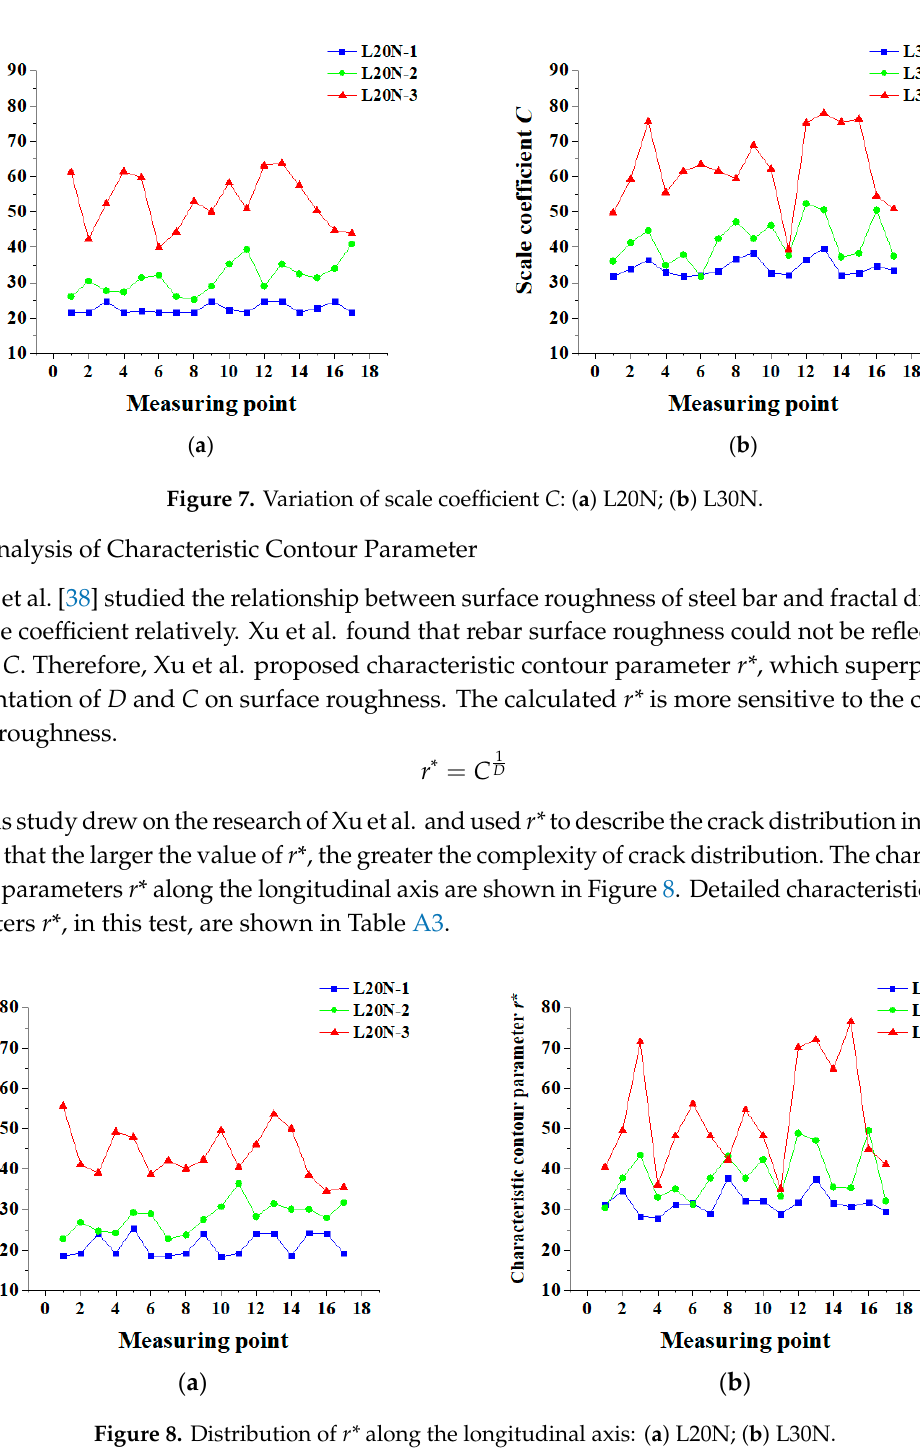
( b ) Figure 6. Variation of fractal dimension D : ( a ) L20N; ( b ) L30N. As can be seen from Figure 6, most of the fractal dimensions are between 1.0 and 1.1. According to Li et al. [45], the fractal dimension mainly describes the complexity of cracks, which can reflect the